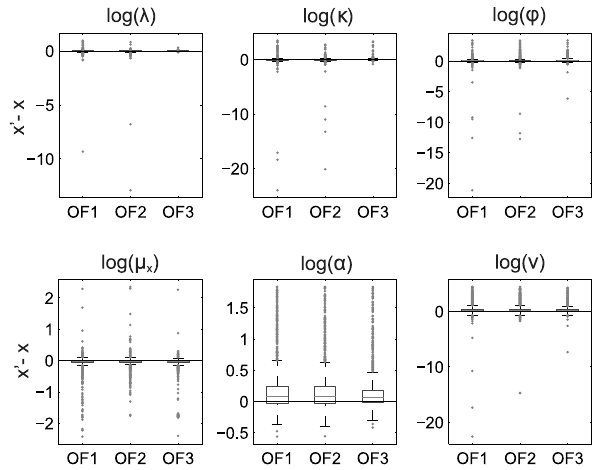
Fig. 5. Distributions of estimation error for each parameter, grouped according to the used optimization method.